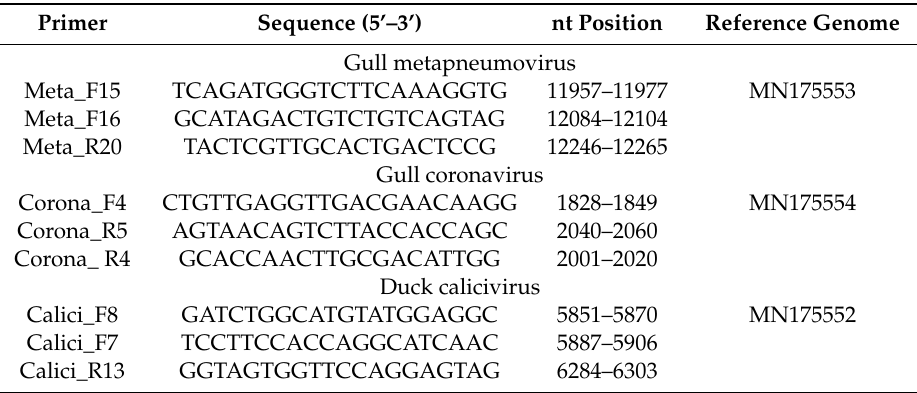
Table 1. Primers used for molecular